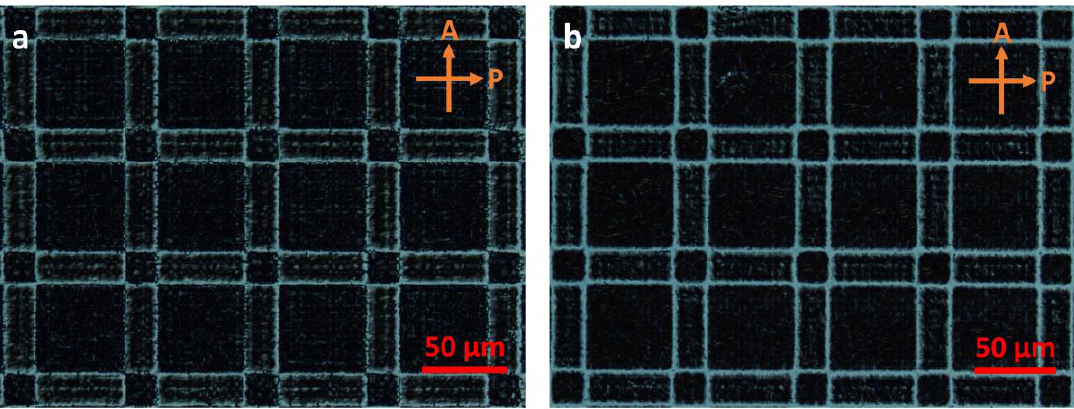
Figure 4. Polarized optical microscope image of the fabricated LC Dammann grating: ( a ) reference grating (period ~72 μm), ( b ) designed grating (period ~75 μm). A: analyzer; P: polarizer.